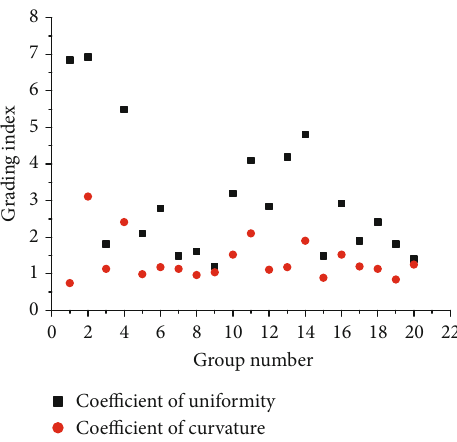
Figure 5: Grading indexes of experimental sands.